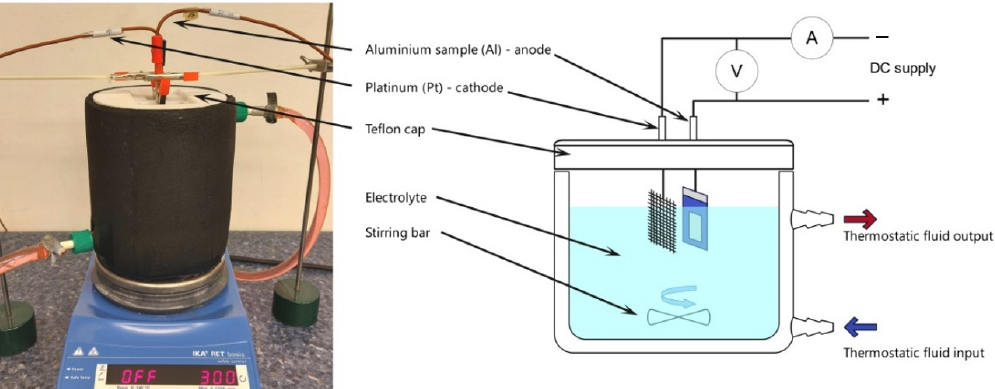
Figure 1. Experimental setup (on the left side—a photo of the electrochemical cell; on the right side—a scheme of the electrochemical units) used during